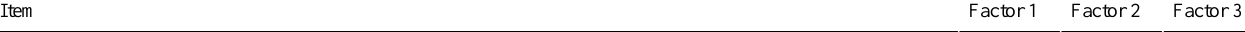
Factor 3Factor 2Factor 1Item –0.0640.121 0.788 S1. The app was easy to